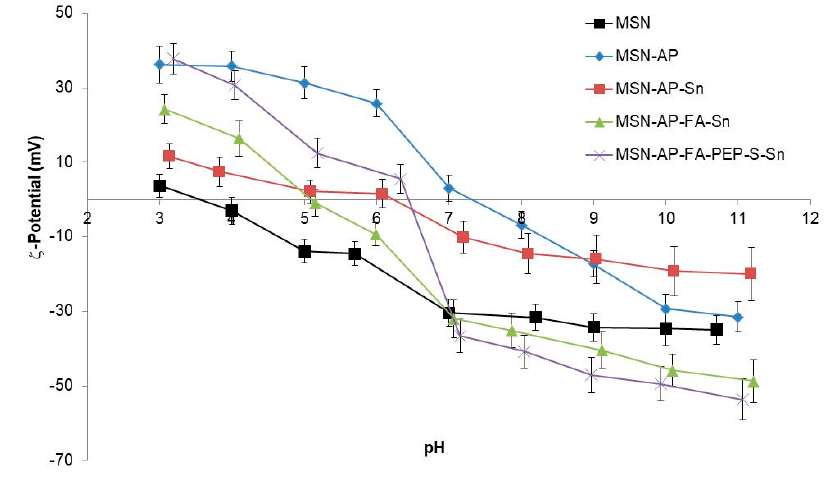
ff erent functionalized Figure 5. Z-Potential of the different functionalized nanoparticles. Figure 5. Z-Potential of the different functionalized nanoparticles. Figure 5. Z-Potential of the di